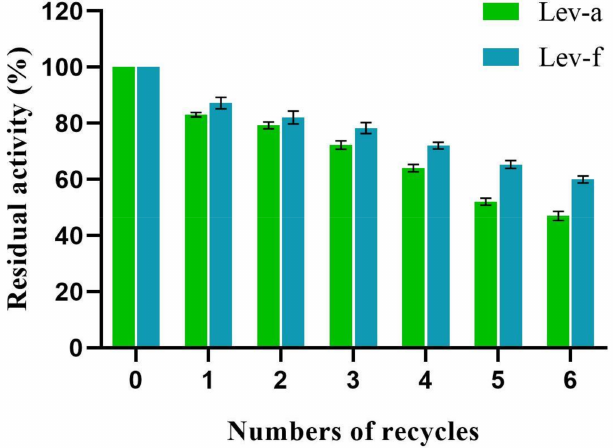
Figure 5. Effect of the number of successive reactions on the levansucrase activity. The residual activity was determined by assuming that the first-round activity was 100%. Lev-a, levansucrase displayed with a-agglutinin; Lev-f, levansucrase displayed with Flo1p. (Experiments were performed in triplicates, and error bars represent one standard